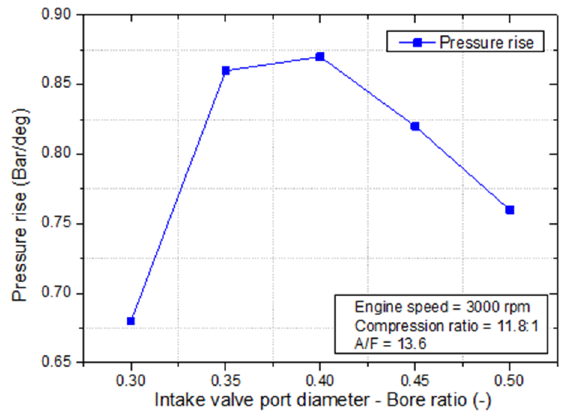
Figure 7. Pressure rise versus IPD/B.